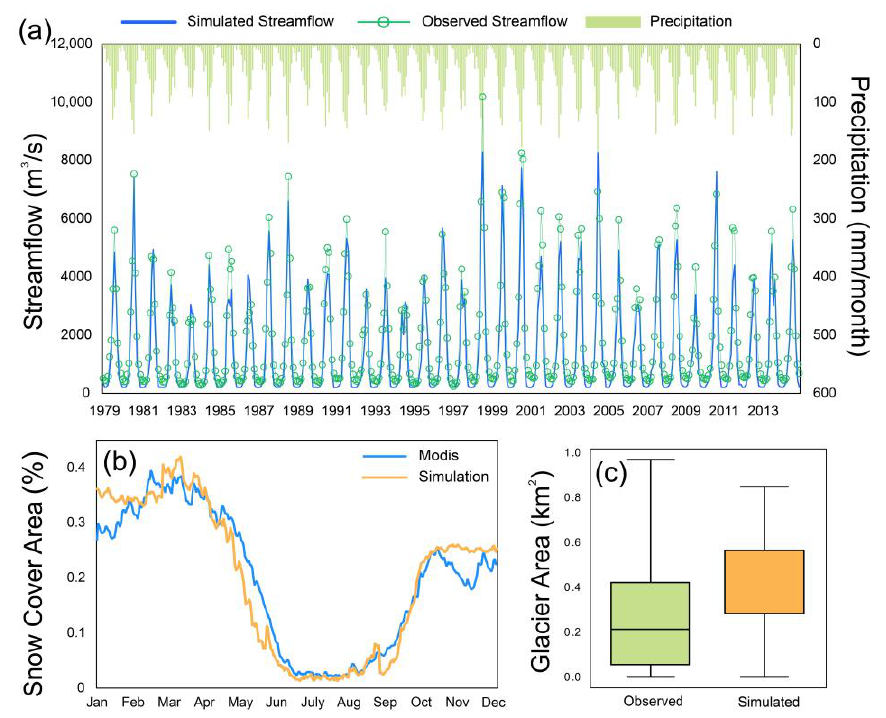
Figure 5. Results of the streamflow ( a ), snow cover area ( b ), and glacier area ( c ).